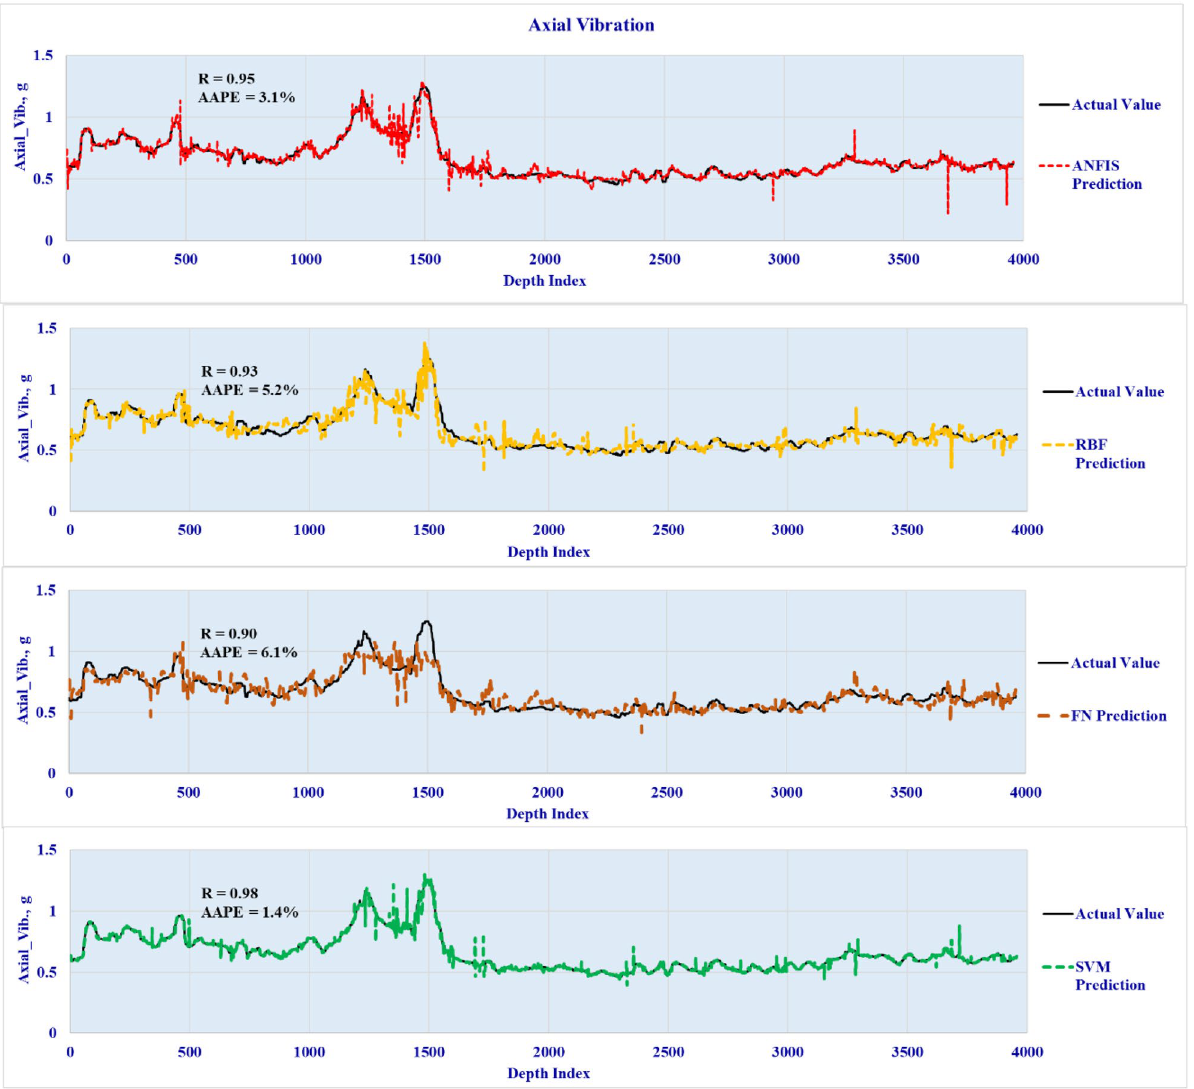
Figure 8. Axial vibration prediction results (Validation well data